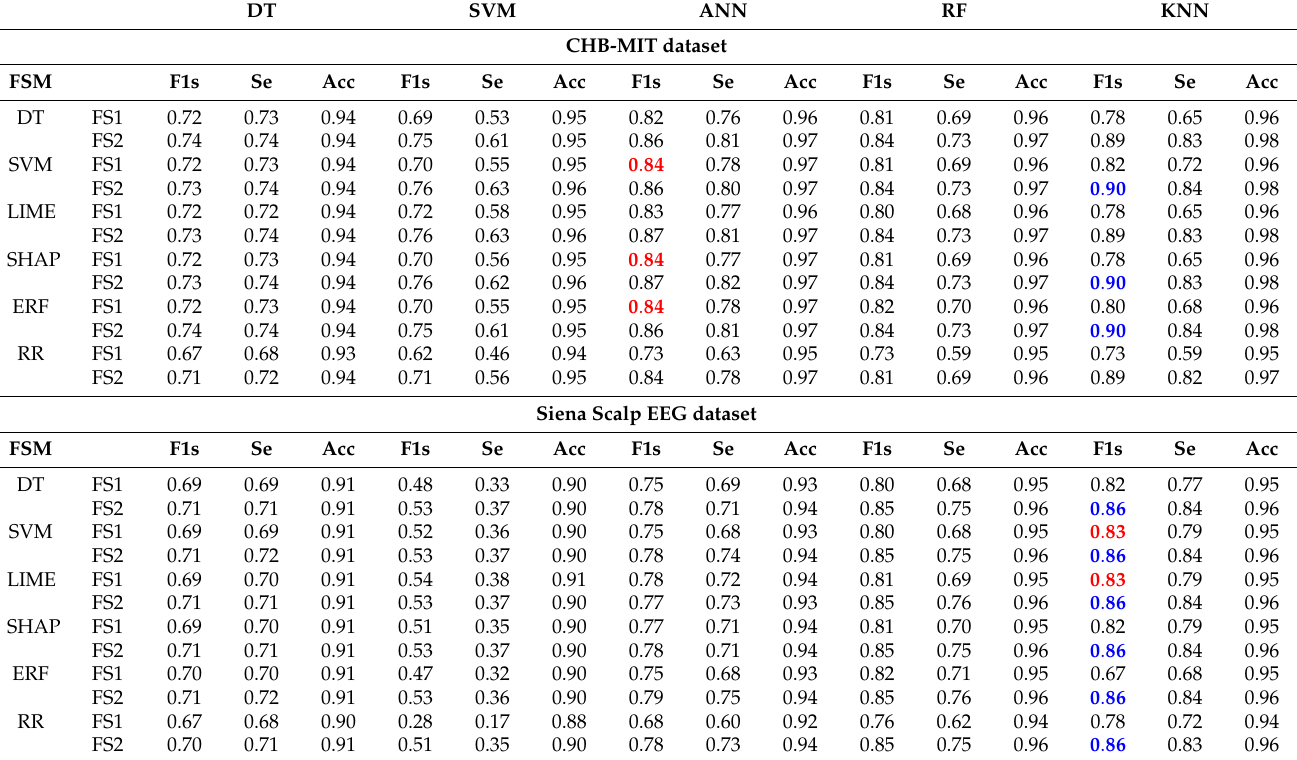
Table 6. Performance comparison using 450 features. The largest F1-scores are displayed in red bold and blue bold for FS1 and FS2, respectively. F1s = F1-score, Se = sensitivity, Acc = accuracy. DT SVM ANN